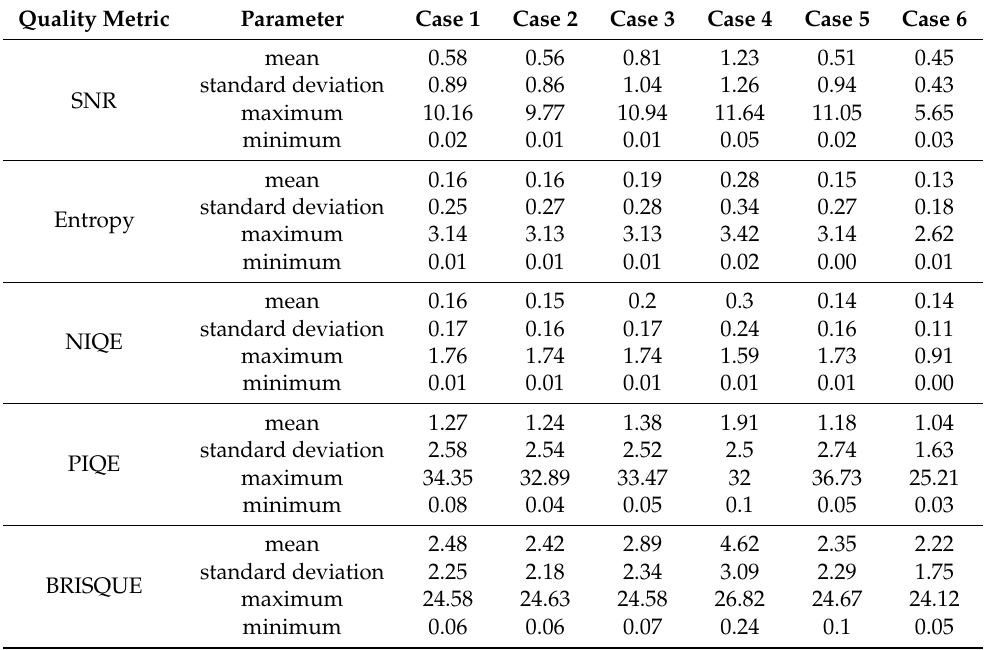
Table 2. Statistics of RMSE values of determining SNR, NIQE, PIQE, BRISQUE, NRPBM, and Entropy indices in 6 variants of the a priori parameter